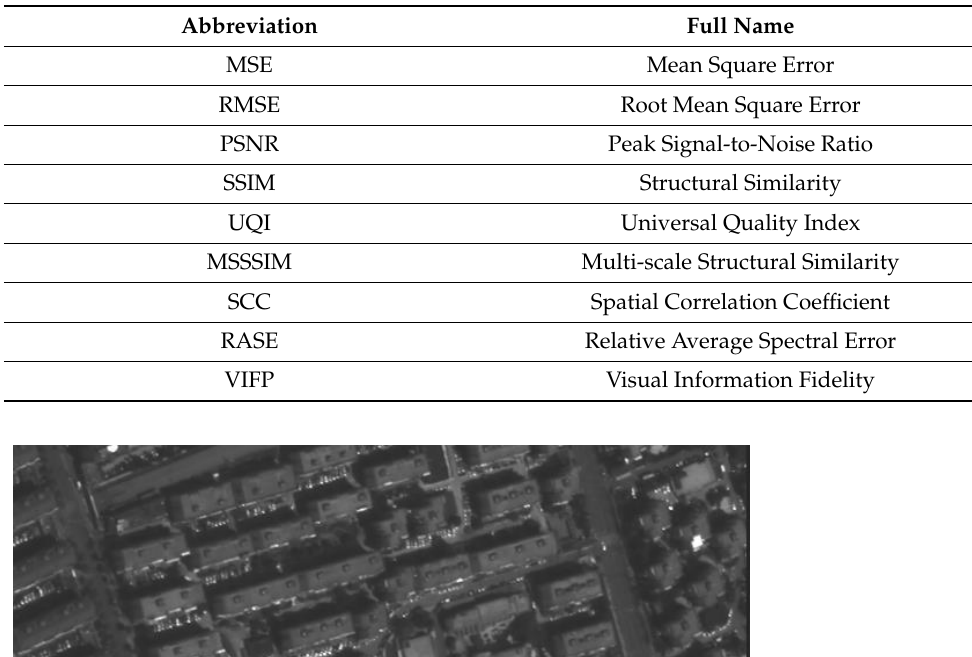
Table 3. The main indices of the image compression.